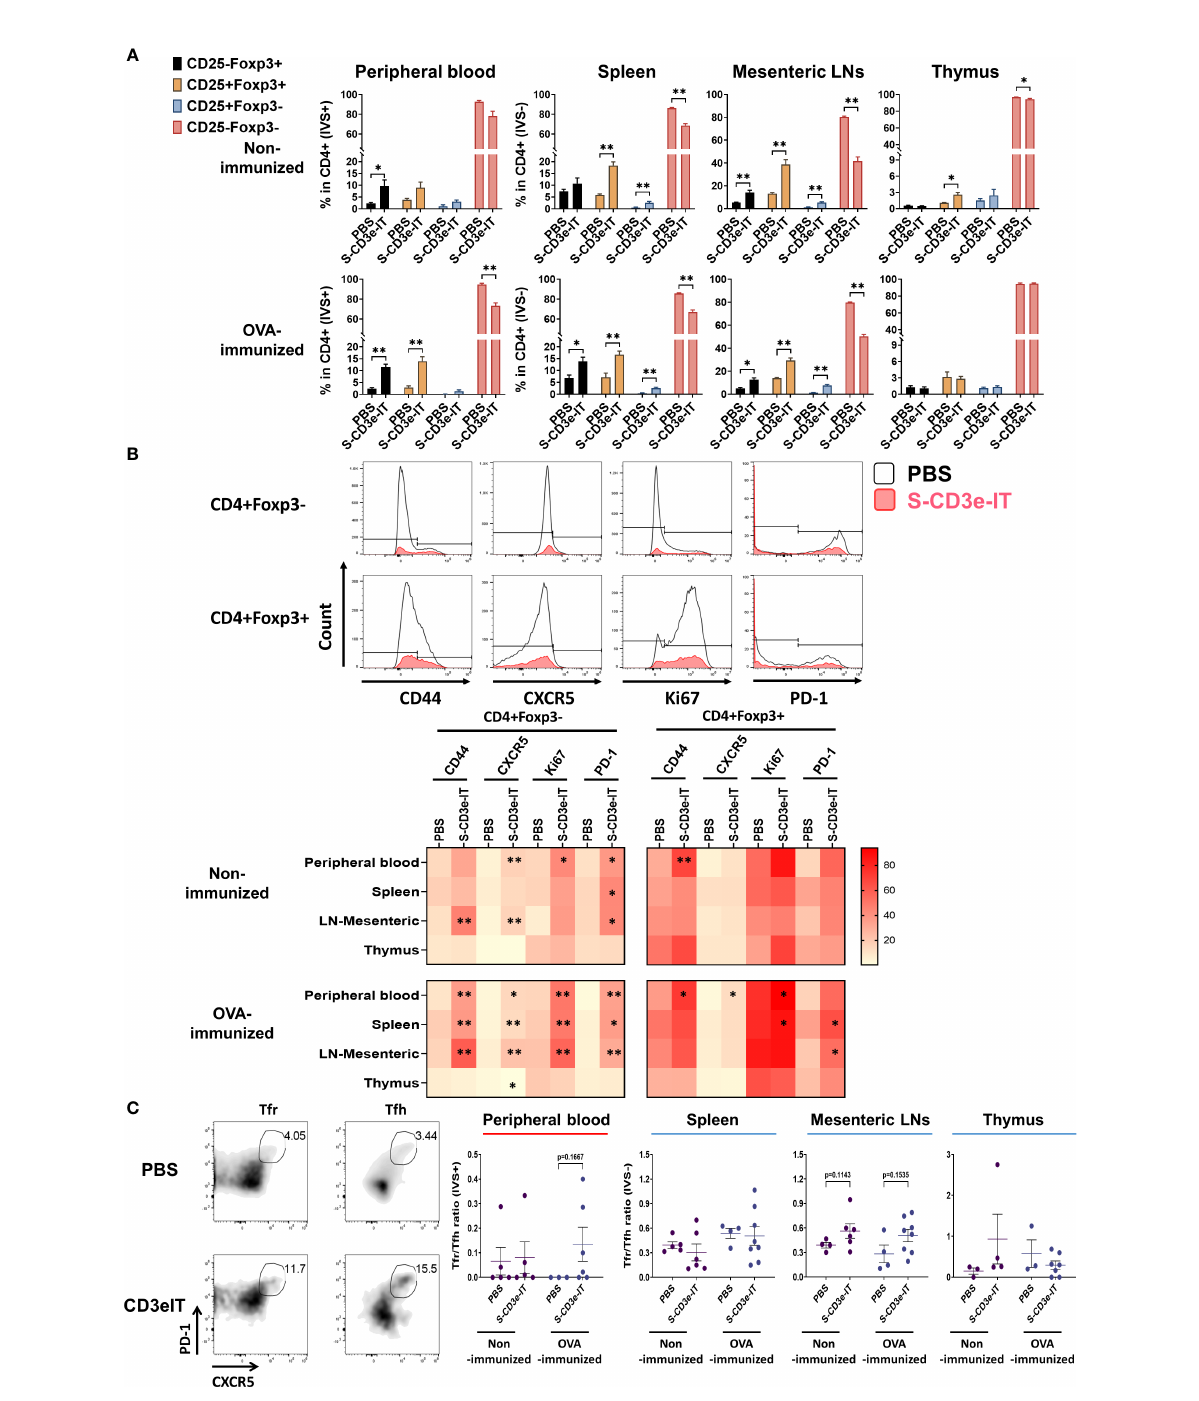
FIGURE 4 Changes in the functional phenotype of T cells after CD3e-IT treatment. (A) S-CD3e-IT treatment enriched CD25+ Tregs cells. CD25+ population (% in CD4+ cells) is shown for the peripheral blood and tissue-resident (IVS-) portions of spleen, mesenteric LNs, and thymus in PBS and S-CD3e-IT treated mice. (B) The fl ow gating strategy is shown to de fi ne CD44+, CXCR5+, Ki67+, and PD-1+ cells in CD4+Foxp3- and CD4 +Foxp3+ cells (Upper panel). The heat map shows four functional phenotypic changes (light red to dark red) of CD4+Foxp3- and CD4+Foxp3+ T cells following S-CD3e-IT treatment (Lower panel). Statistical comparison between PBS-treated vs. S-CD3e-IT-treated mice is denoted with an asterisk (*) on the Heat map. (C) The fl ow cytometry gating strategy is shown to de fi ne CXCR5+PD-1+ Tfr or Tfh. The CXCR5+PD-1+ Tfr-to- CXCR5+PD-1+ Tfh ratios are shown for peripheral blood and tissue-resident (IVS-) portions of the spleen, mesenteric LN, and thymus. Nonimmunized mice were treated with PBS ( n = 4~5, depending on organs) or S-CD3e-IT ( n = 4~6). OVA-immunized mice were treated with PBS ( n = 3~4) or S-CD3e-IT ( n = 7~8). (* p < 0.05 and ** p <